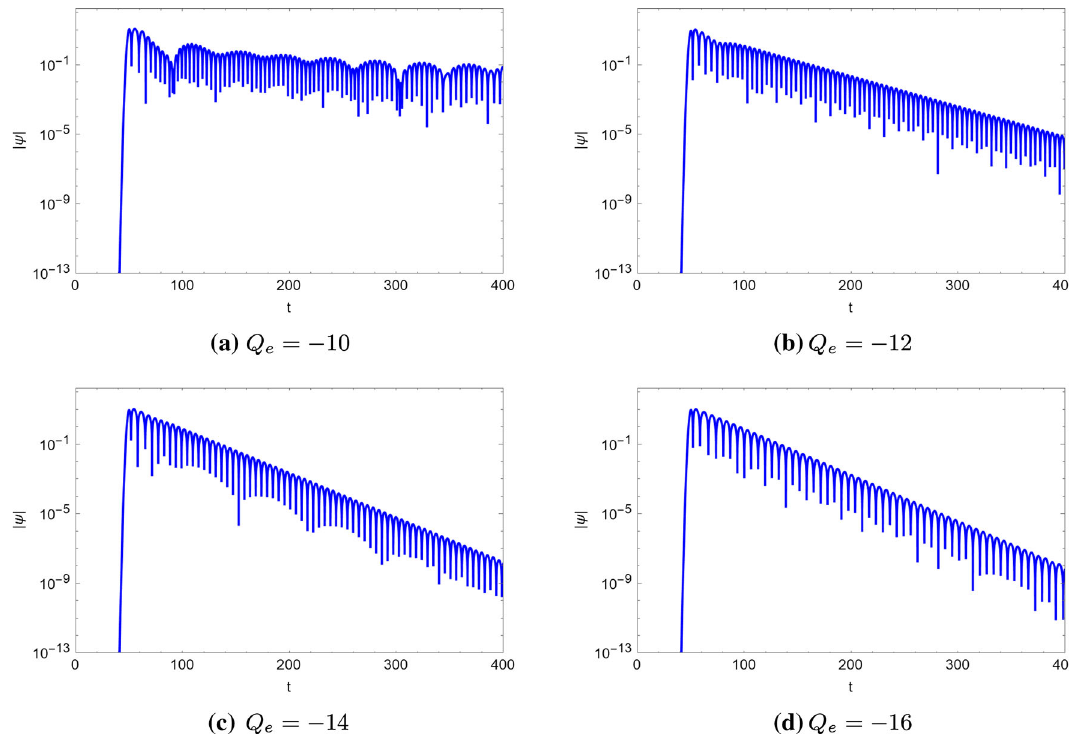
Fig. 8 The time evolution profiles with different Q e . We set l = 2 , M = 0 . 147059 ,γ 1 = − 10 ,γ 2 = 2